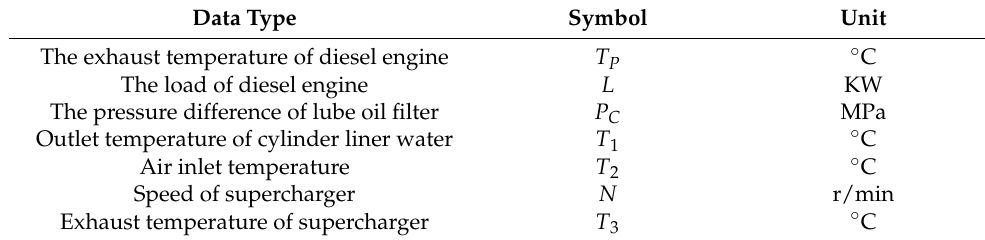
Table 1. Type of